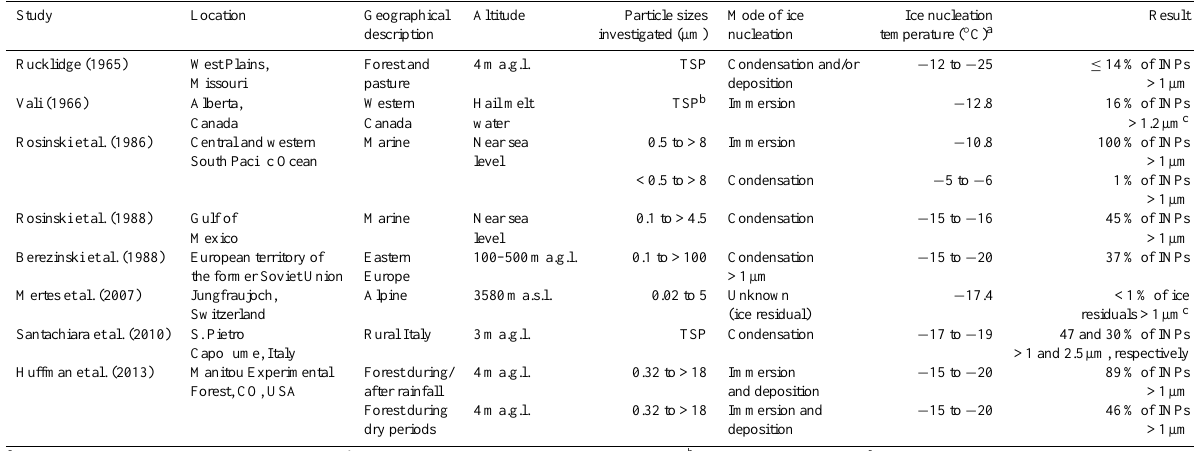
Table 2. Previous size-resolved INP measurements.